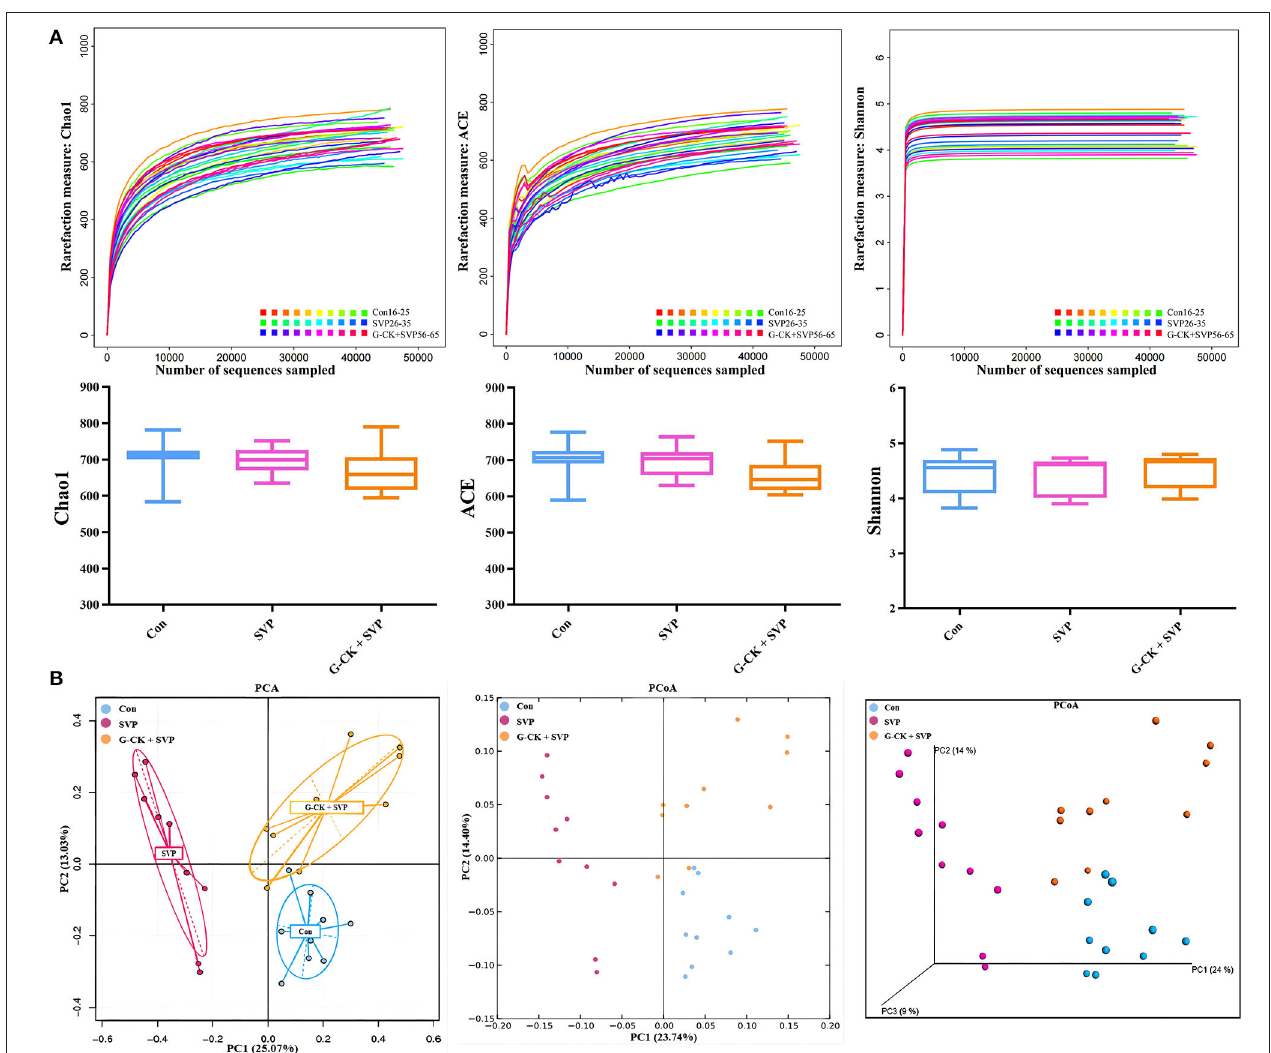
FIGURE 1 | Alpha diversity and beta diversity of gut microbiota. (A) Alpha diversity. Data are expressed as median and min-to-max values, n = 10. (B) Principal components analysis (PCA) and principal coordinate analysis (PCoA), n = 10. Con, control; SVP, sodium valproate (500 mg/kg, twice daily); G-CK, ginsenoside compound K (320 mg/kg, once